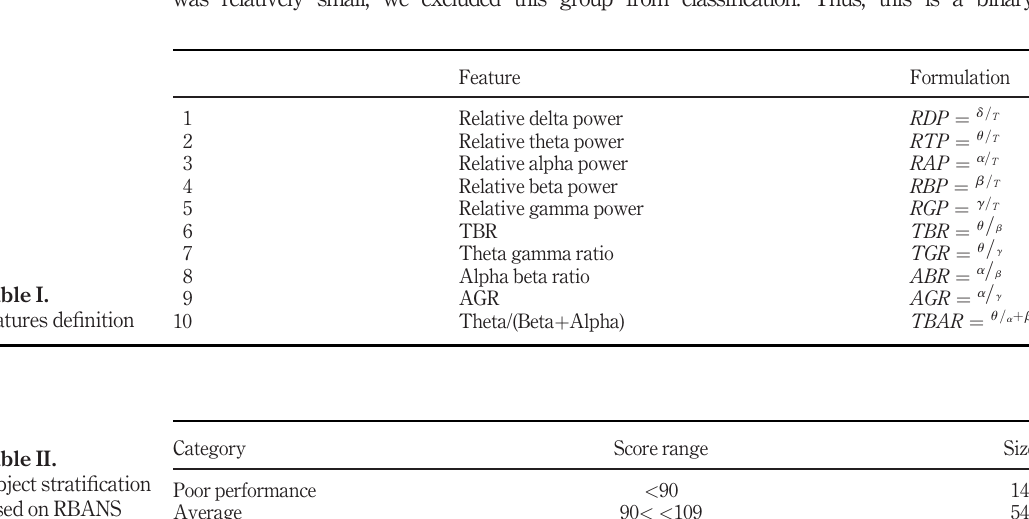
based on RBANS attention